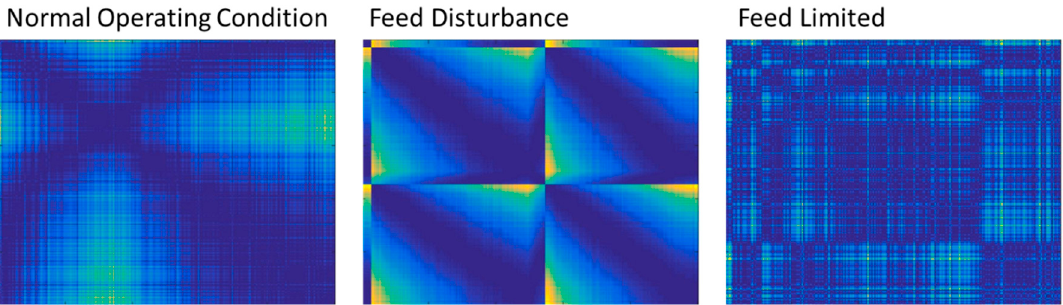
Figure 13. Representative plot of the Euclidean distance matrices of three control states of the autogenous mill, i.e., normal operating conditions (left), feed disturbance (middle) and a feed limited state (right). Small values are indicated by dark blue colors on the one extreme, while large distance values are indicated by bright yellow colors.